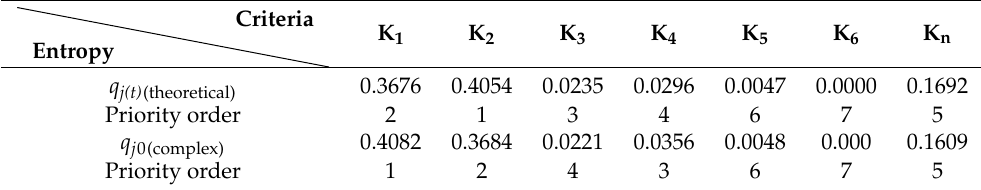
Table 20. The theoretical and complex importance of